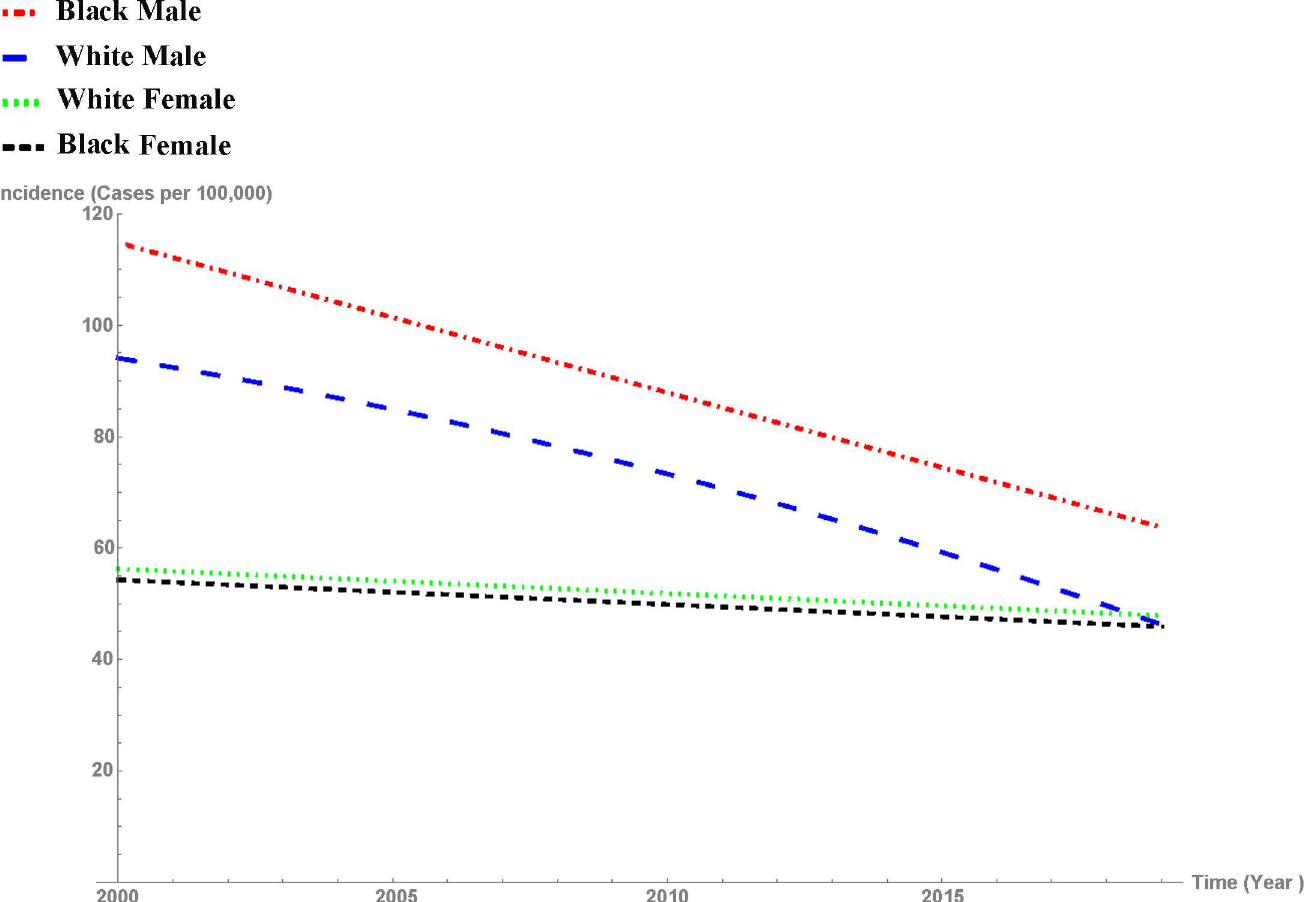
Fig 1. Predictive curves of lung cancer incidence rates by race and gender (cases per 100,000).